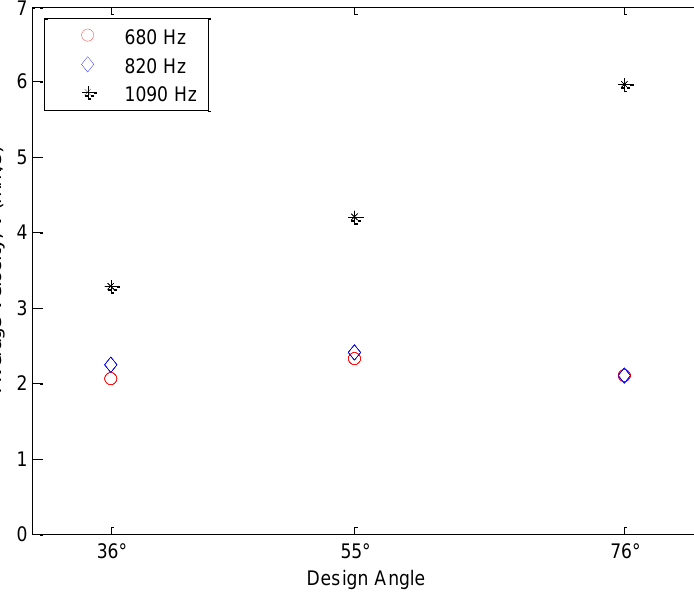
Figure 15. Results showing the dependence of angular velocity on front leg